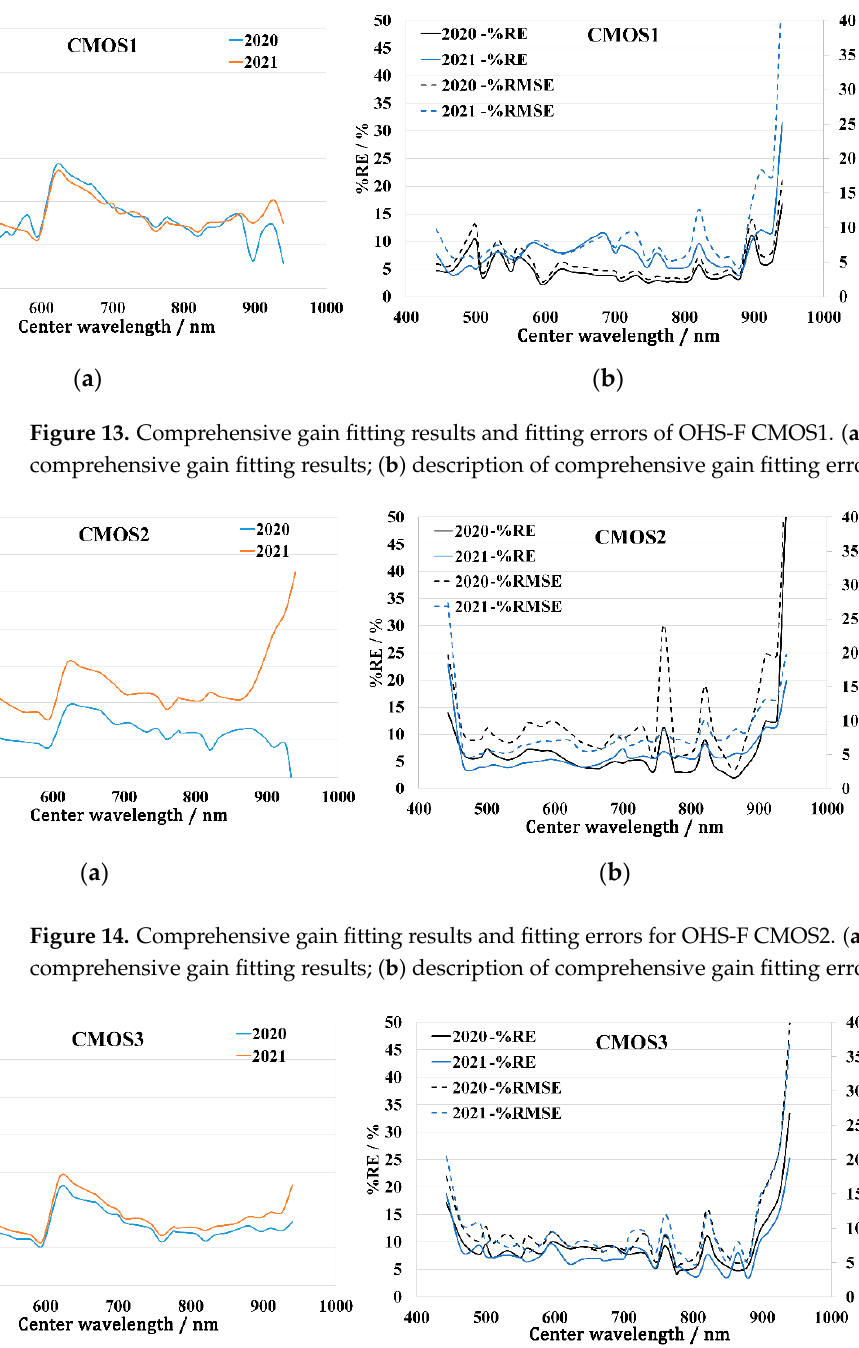
Figure 14. Comprehensive gain fitting results and fitting errors for OHS-F CMOS2. ( a ) Description of comprehensive gain fitting results; ( b ) description of comprehensive gain fitting error.